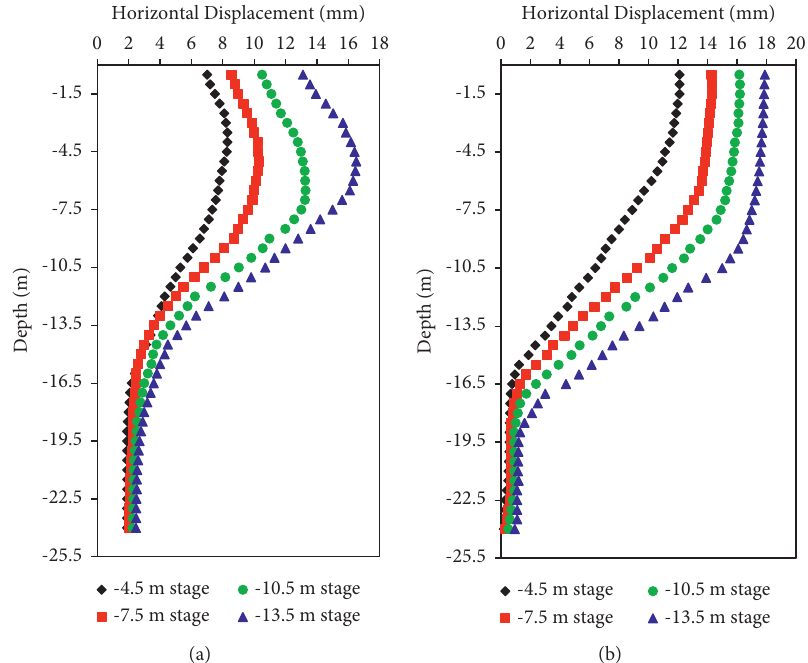
Figure 17: Influence of the optimum servo steel axial loading capacity application on cumulative horizontal displacement at the actual site. (a) ZQT21. (b)